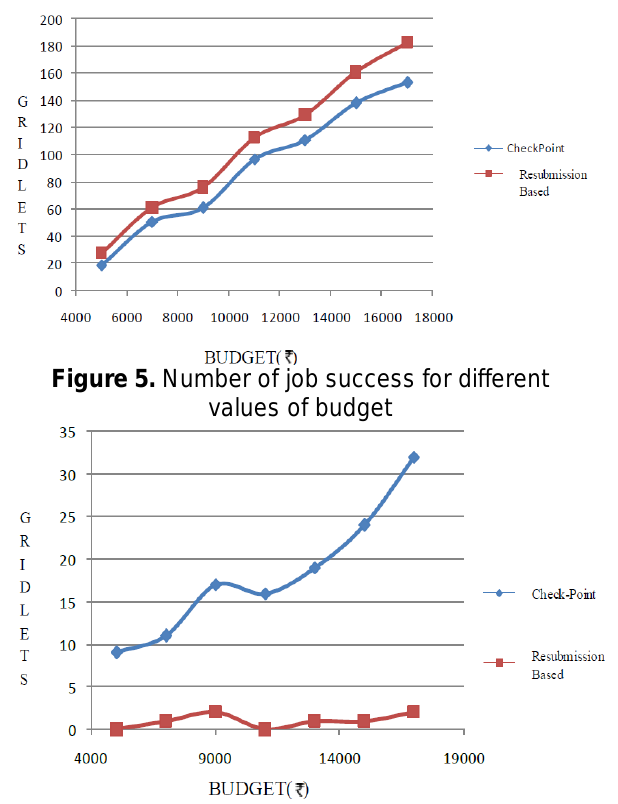
Figure 6. Number of jobs fails to achieve the